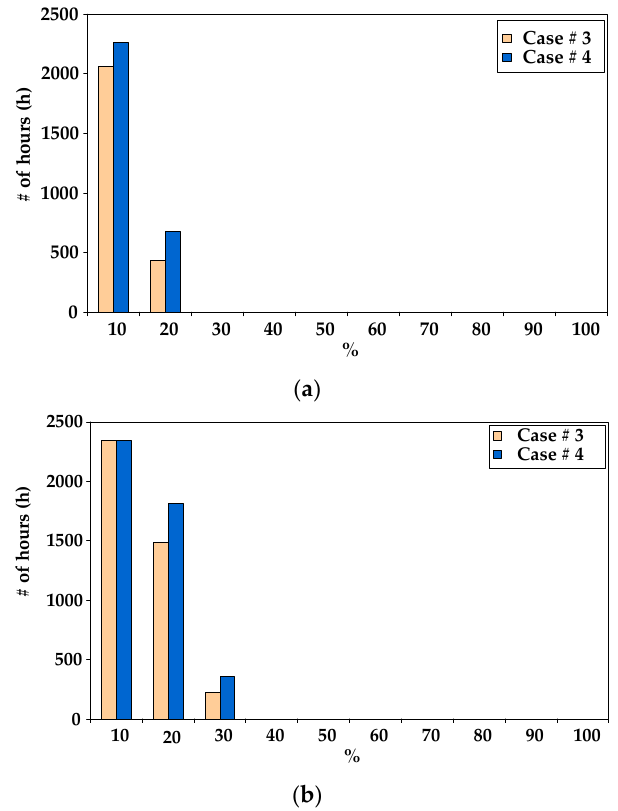
Figure 9. Percentage of occupant dissatisfied with the indoor environment: ( a ) female, light clothes, moderate workload; ( b ) male, light clothes, moderate workload.